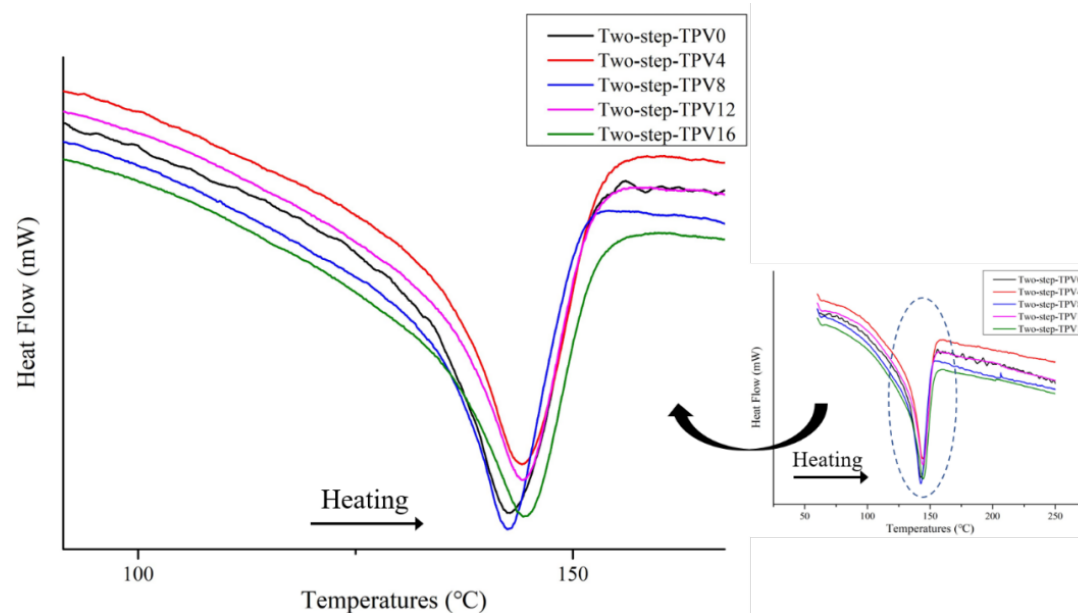
Figure 6: Melting curves of two-step-TPV with different content of CB.